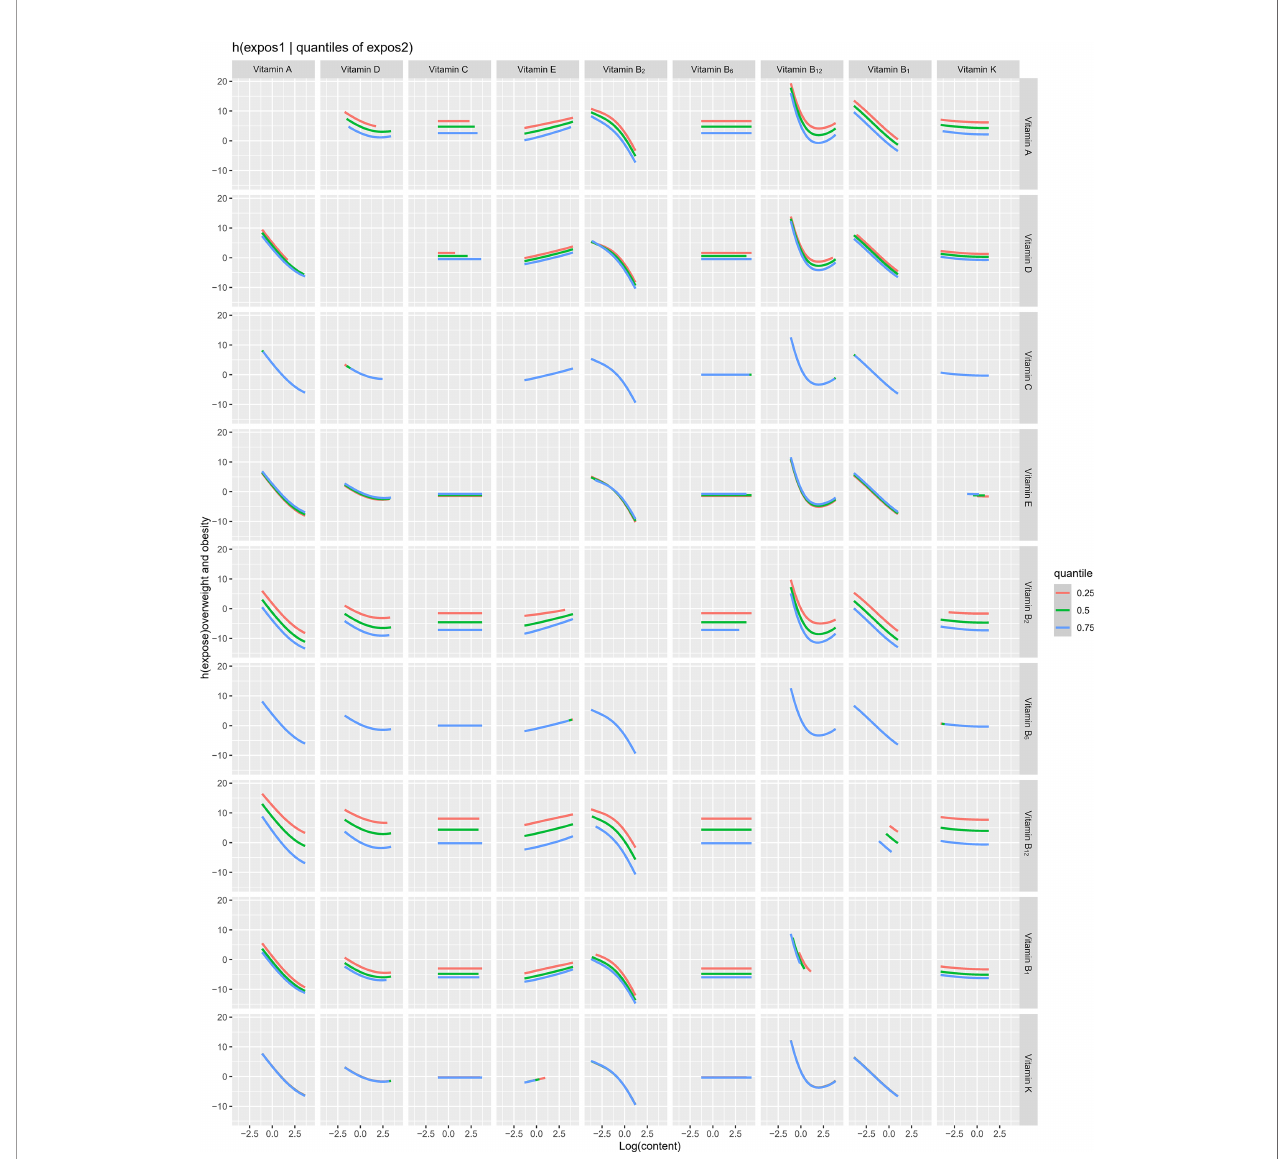
FIGURE 4 | Bi-variate exposure response functions of each two vitamins in obesity among children and